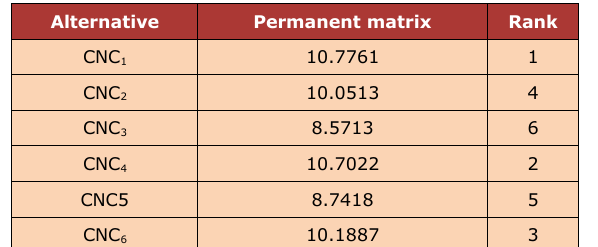
Table 17. Ranking